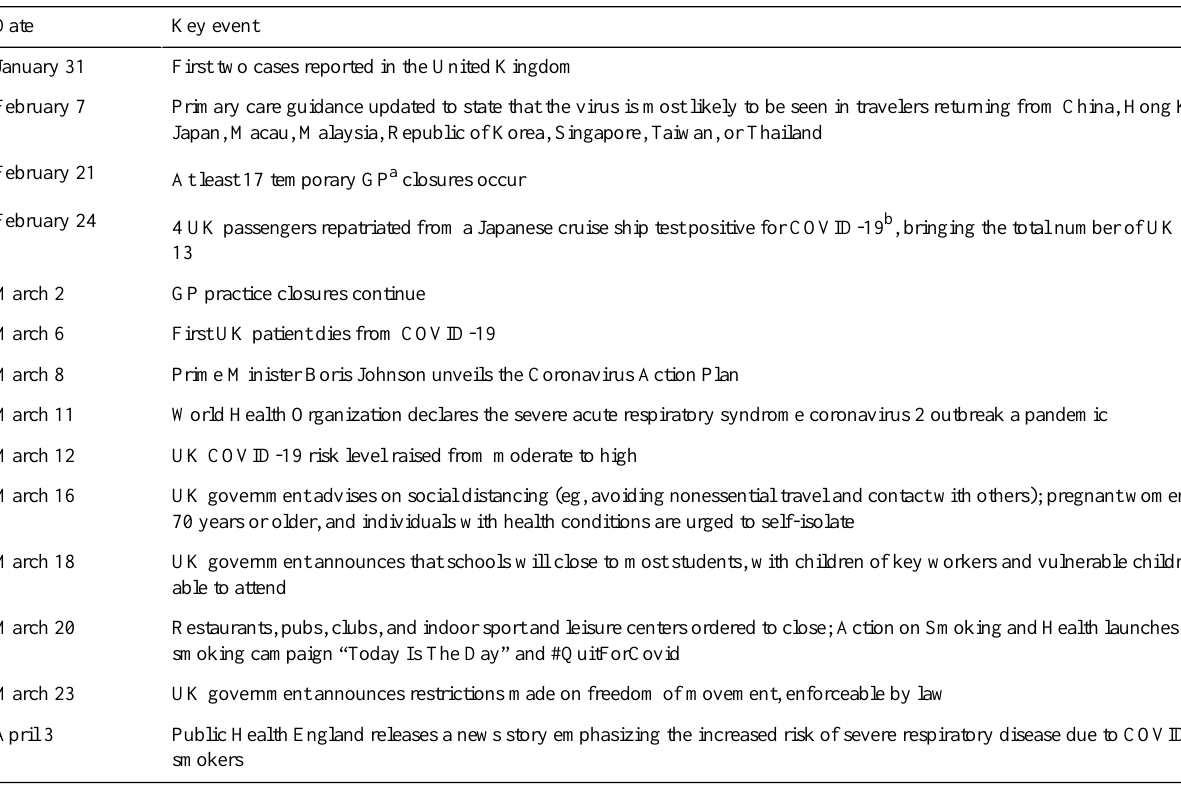
Table 1. Timeline of key UK events in 2020 related to smoking and COVID-19, including government policies and legislation